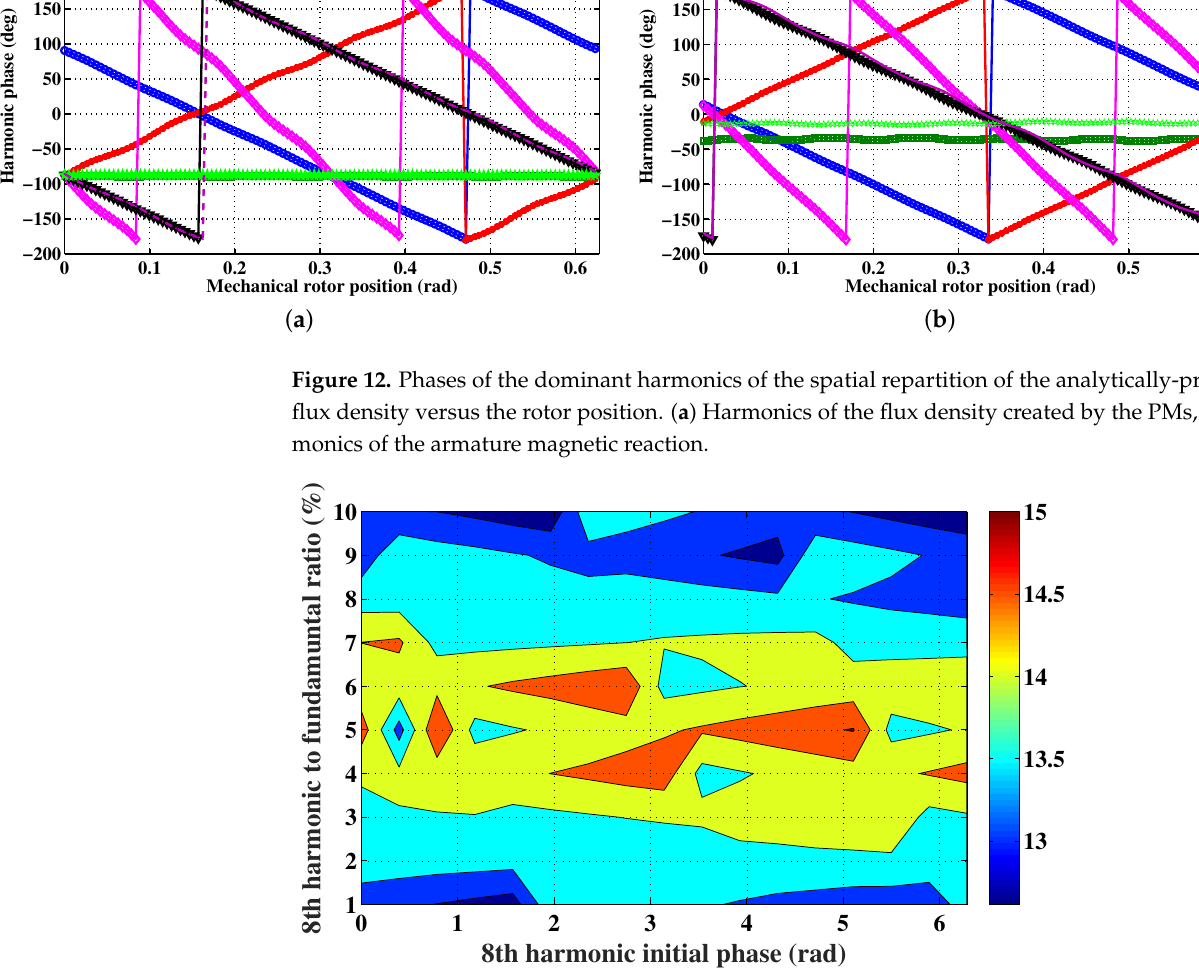
Figure 13. Mapping of the mean total torque developed following the injection of an harmonic current of rank 8, plotted in the plane (8th harmonic initial phase, 8th harmonic amplitude to fundamental amplitude